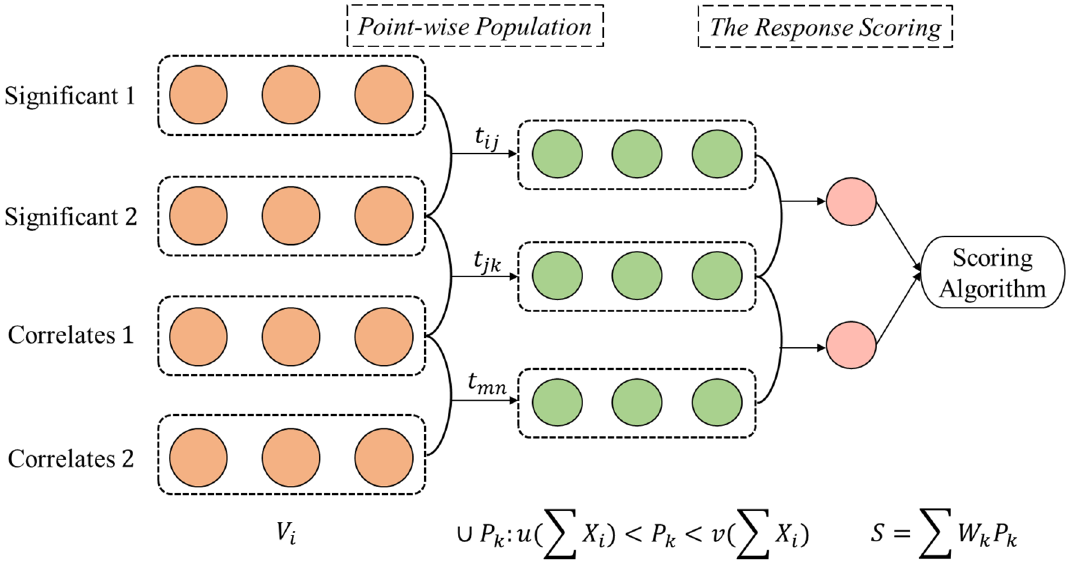
Figure 5. Process-quality machine learning framework overview.